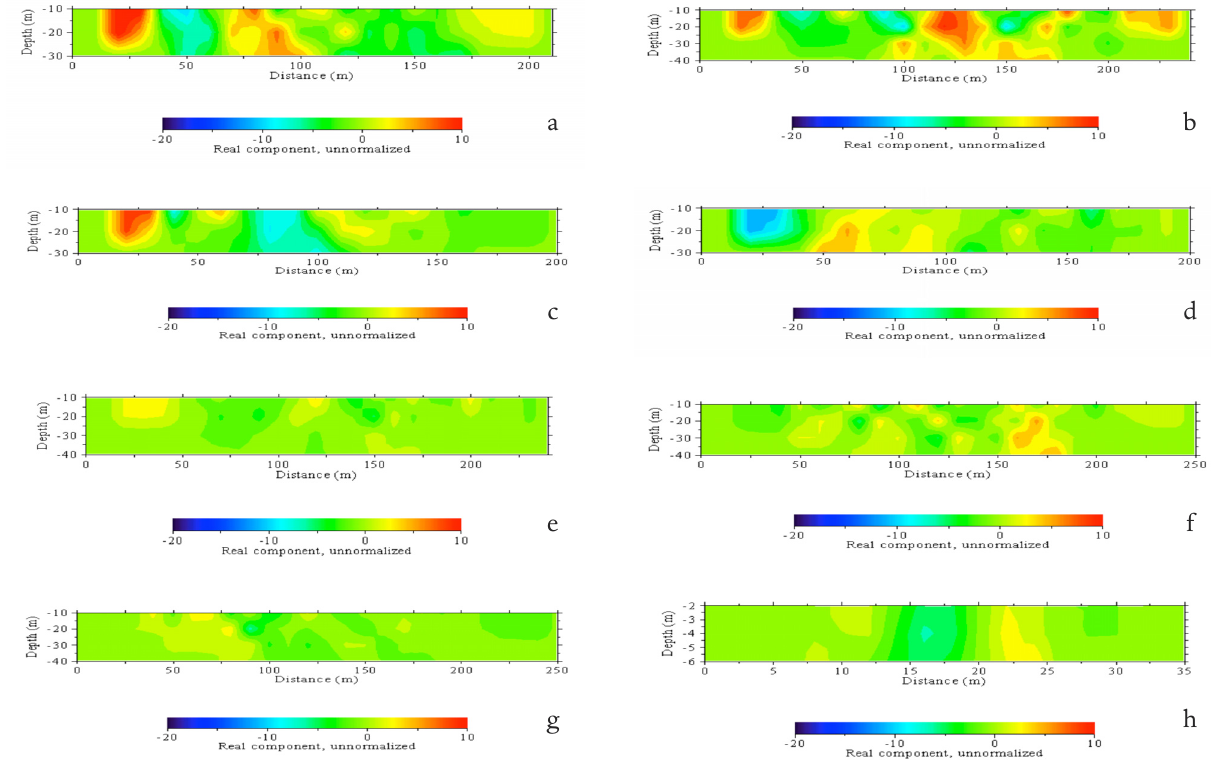
Figure 4. Numerical modeling (KH model) of the inphase component of very low frequency electromagnetic method (VLF-EM) on Fed- eral Housing Estate Irese, Nigeria: (a) Traverse 1, (b) Traverse 2, (c) Traverse 3, (d) Traverse 4, (e) Traverse 5, (f) Traverse 6, (g) Traverse 7, (h) Traverse 8.